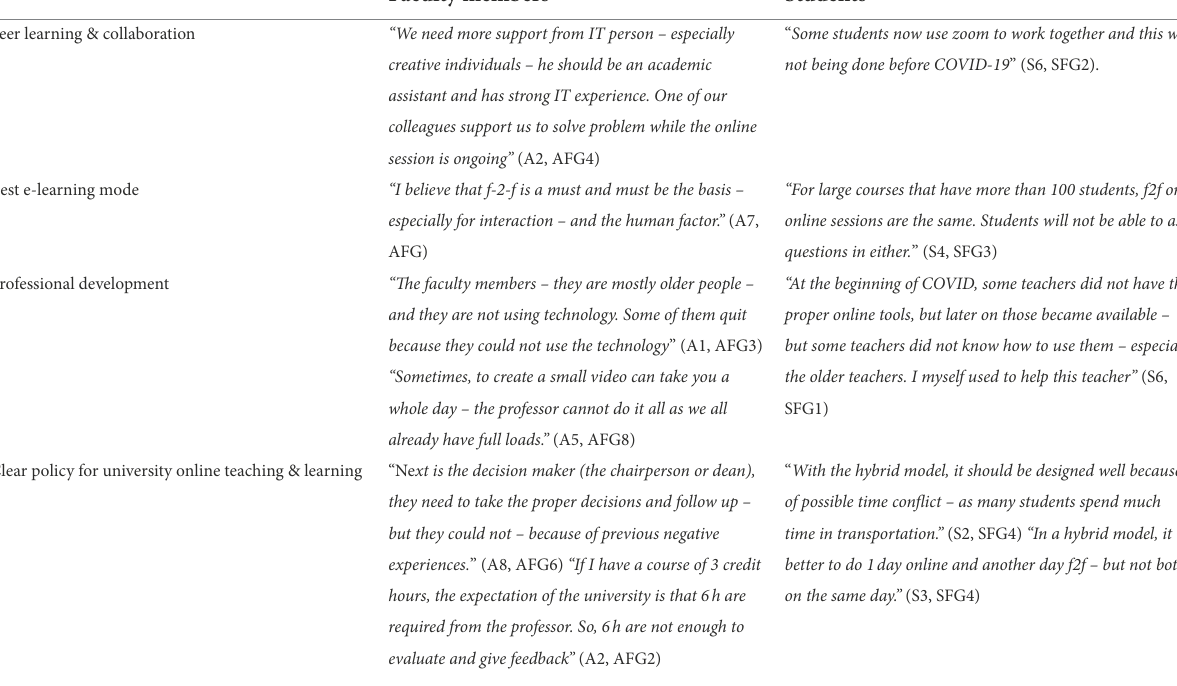
TABLE 9 Lessons learned and future